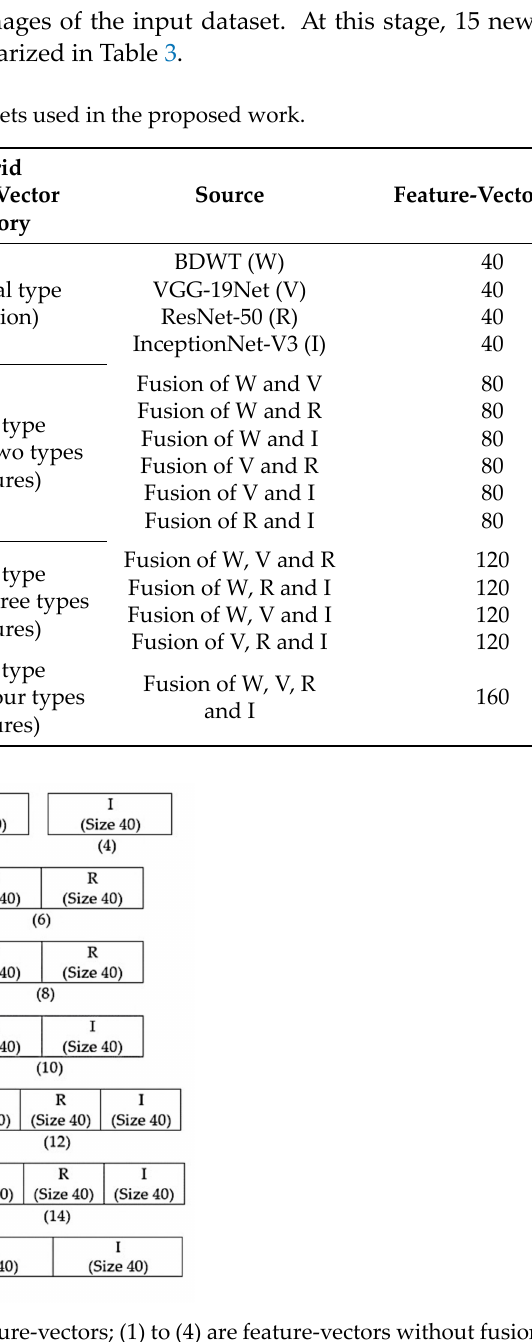
Figure 6. The format of hybrid feature‑vectors; (1) to (4) are feature‑vectors without fusion and they are related to the new datasets—D1 to D4, respectively; (5) to (15) are hybrid feature‑vectors with fusion of 2 or more feature‑types and they belong to new datasets, D5 to D15,